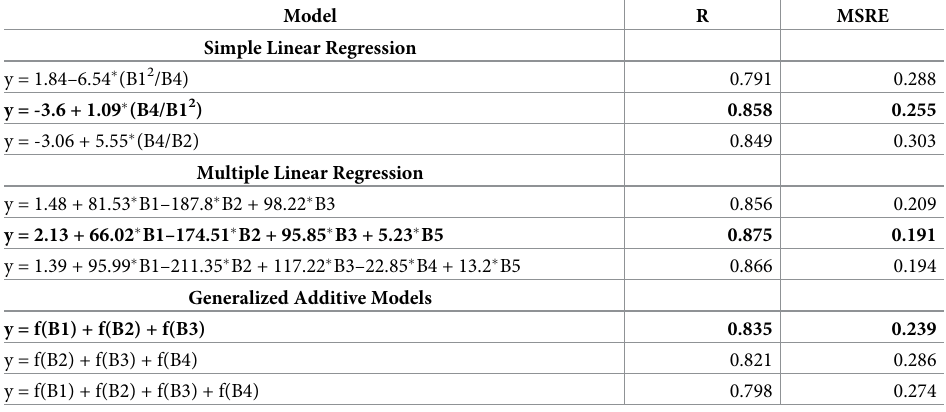
Table 3. Predictive performance of the three best fitted SLR, MLR, and GAM, respectively, applied for log-trans- formed Chl-a estimation. Model R MSRE Simple Linear